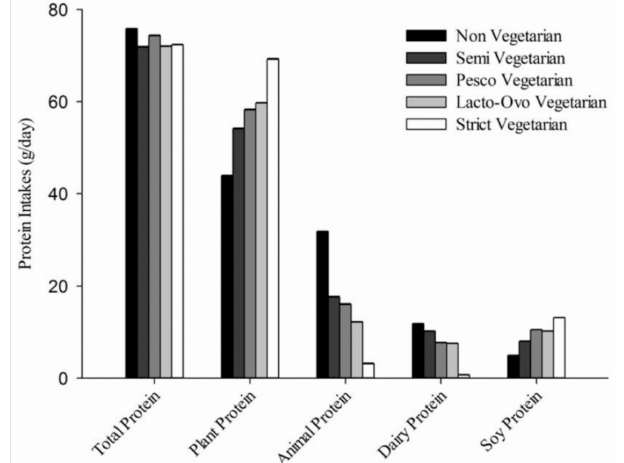
Figure 1. Protein intake (g / day) in the Adventist Health Study 2. From Rizzo and collaborators [9] with